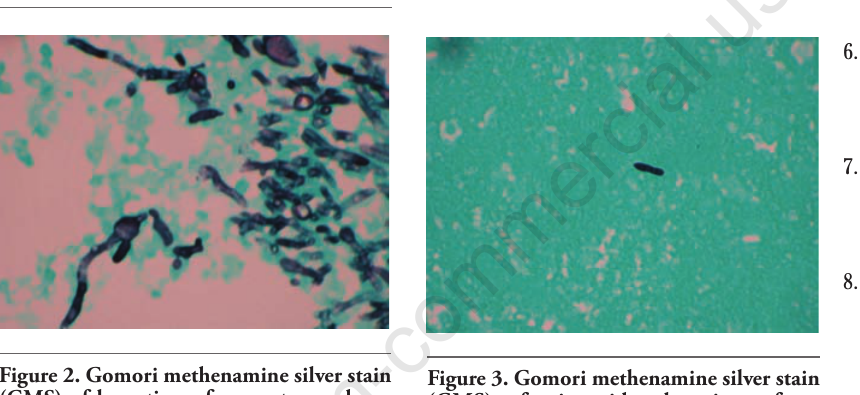
Figure 2. Gomori methenamine silver stain (GMS) of lung tissue from autopsy show- ing branching hyphae characteristic for Aspergillus (200x).